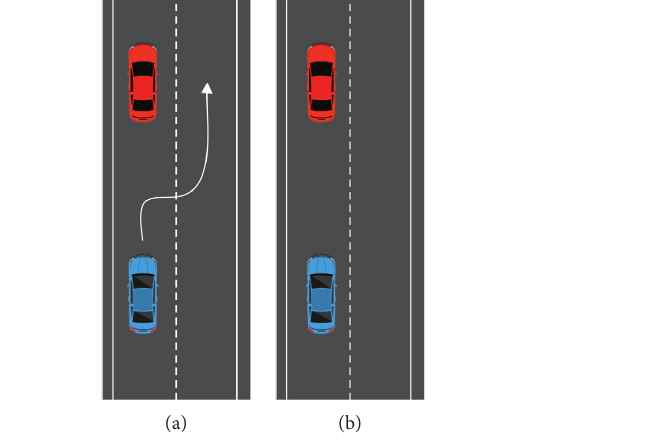
Figure 1: An example of different driving behaviors under same traffic context: (a) aggressive drivers change lane; (b) moderate drivers follow